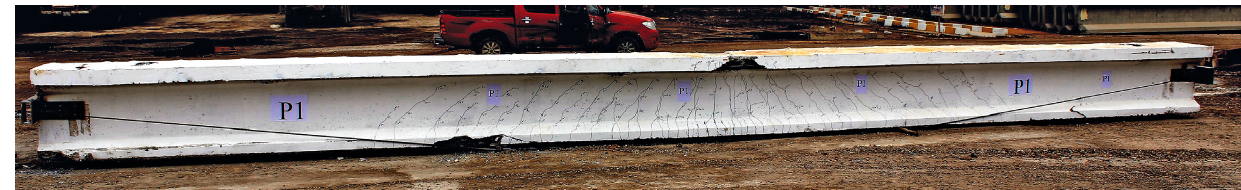
Figure 7: Crack pattern of girder P1 after